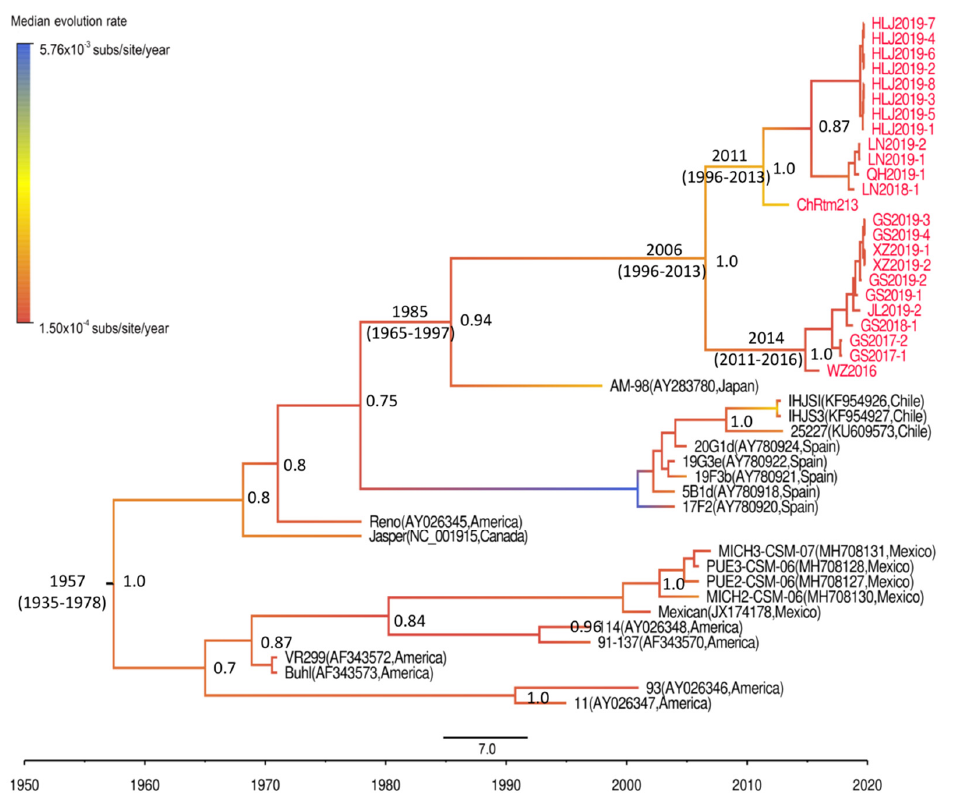
Figure 4. Maximum clade credibility (MCC) tree for genogroup I IPNV strains based on the VP2 gene CDS sequences, constructed using BEAST 1.10.4 software (University of Edinburgh, Edinburgh, UK). Posterior probability values are shown at each node, and branches with different color lines show the median evolution rate of each branch. The divergence time of each node, including the 95% highest posterior density, is shown only when the posterior probability value of the corresponding node is higher than 0.9.